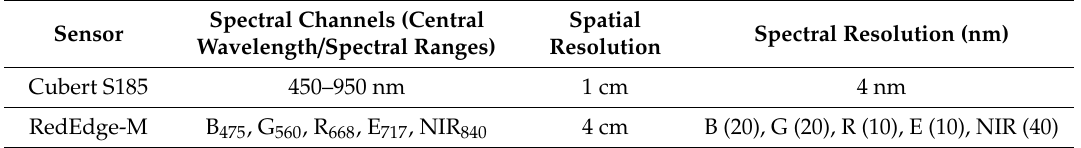
Figure 3. UAV platforms used in this study: ( a ) the DJ M600 Pro six-rotor UAV; ( b ) the DJ M100 four-rotor UAV. Table 5. Specifications of the two cameras used in this